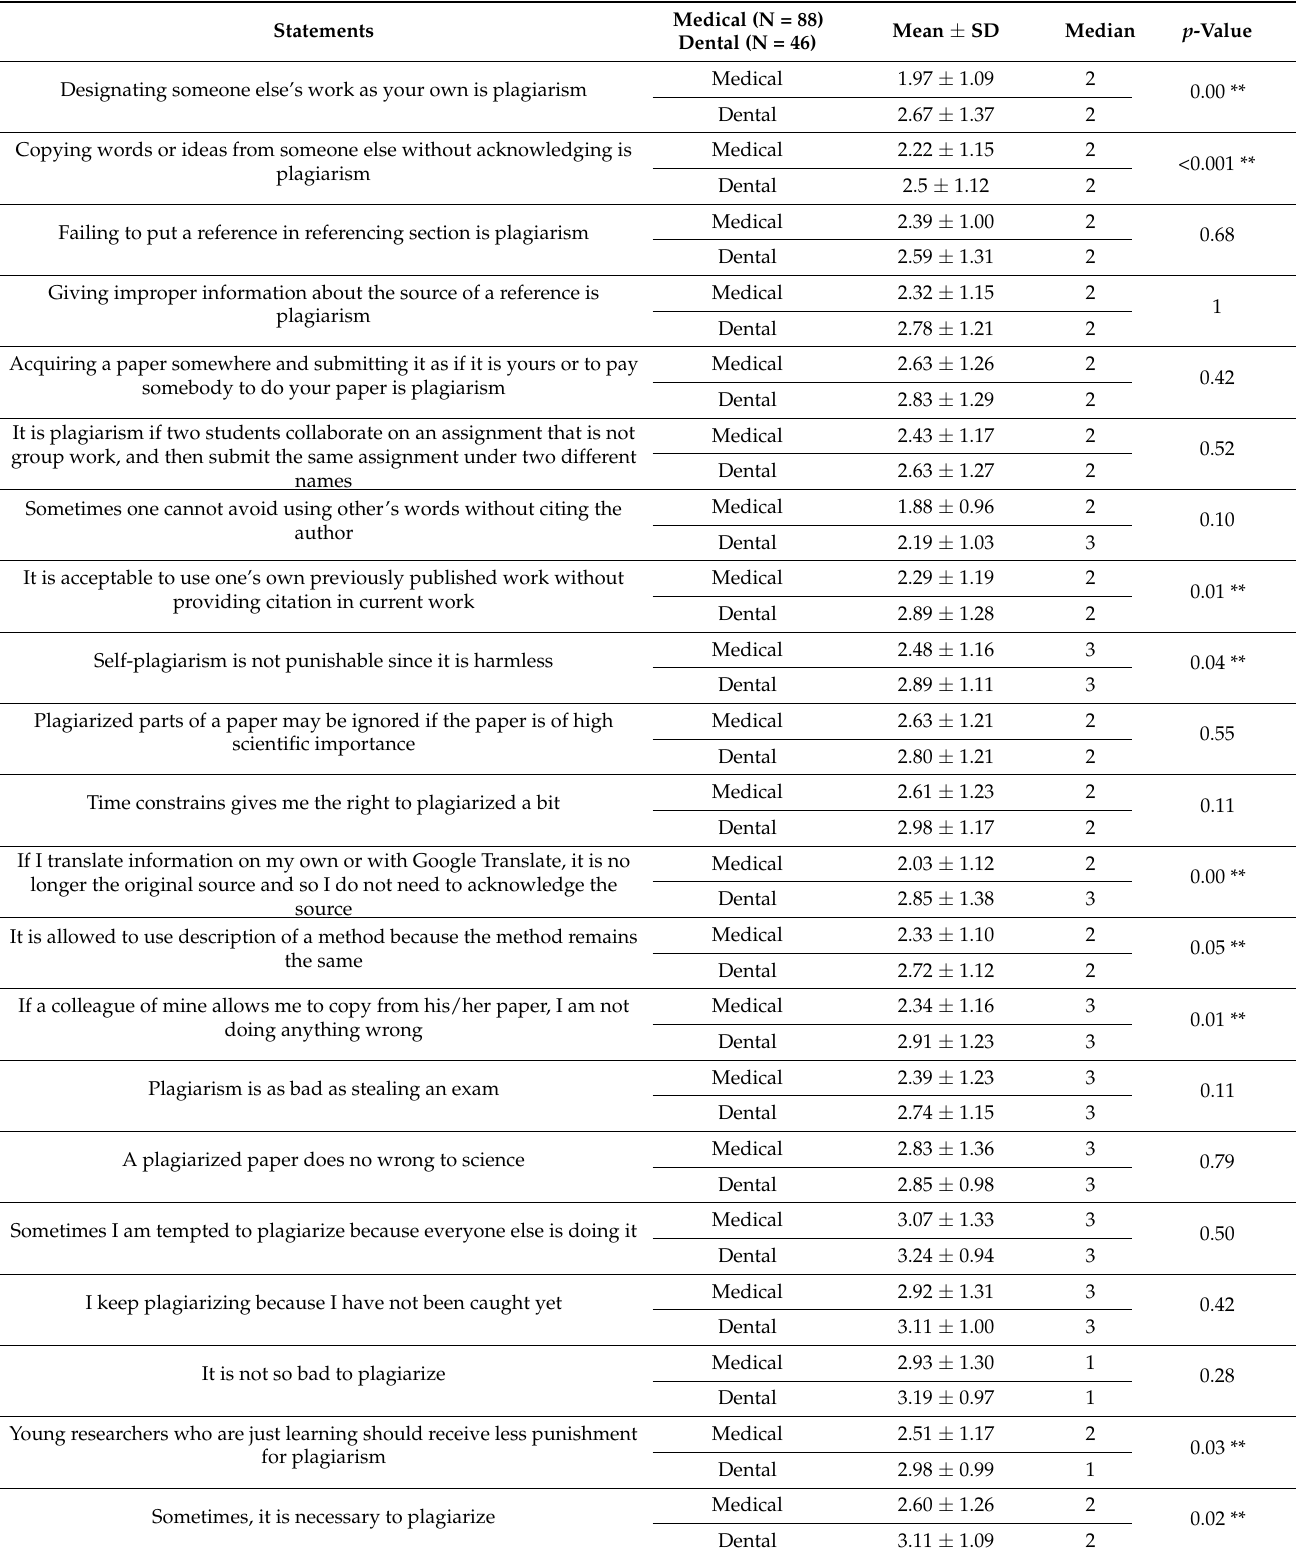
Table 2. Mann Whitney U test results of plagiarism by area of